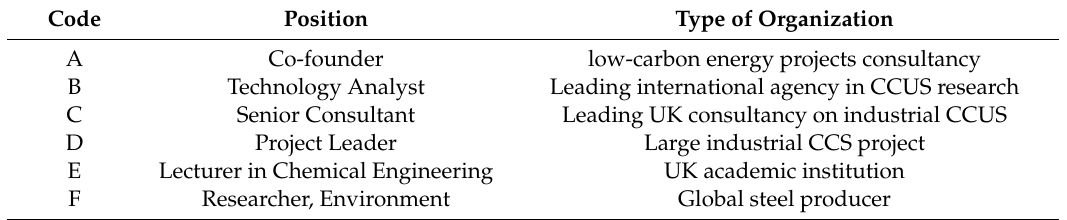
Table 2. List of interviewee roles within their a ffi liation